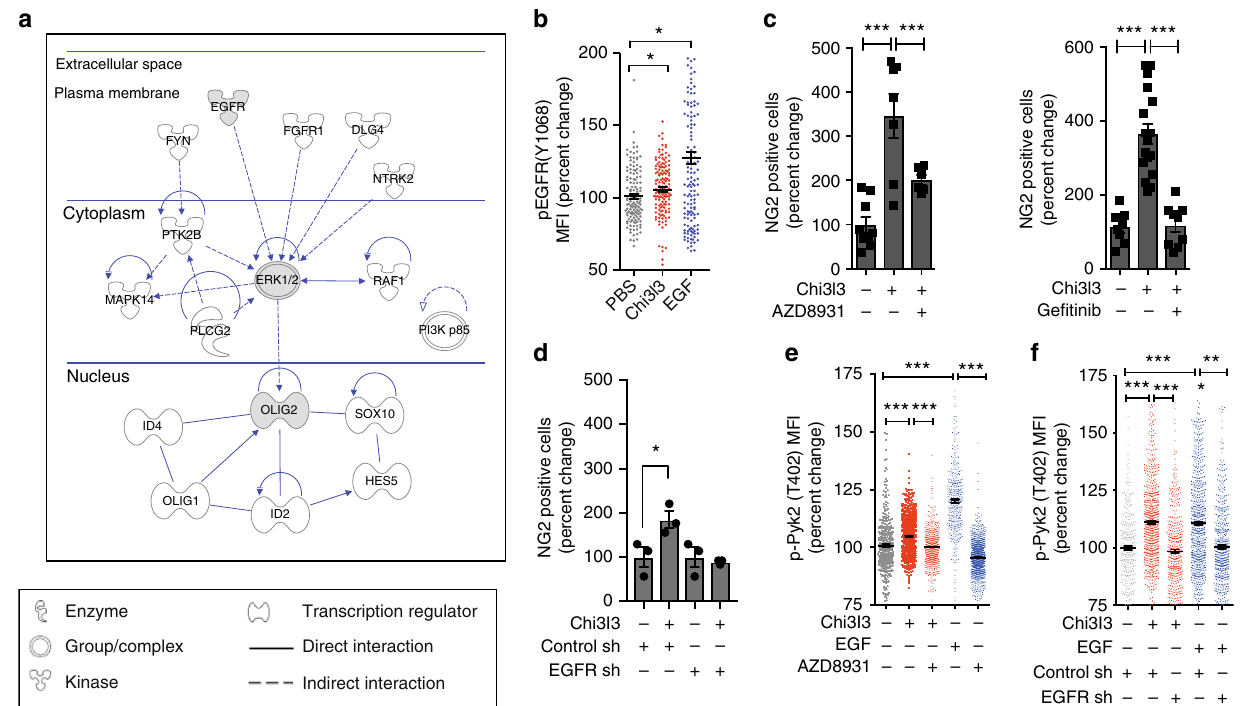
Fig. 4 Chi3l3 promotes oligodendrogenesis by inducing EGFR signaling. a ingenuity pathway analysis showing membrane-bound receptors (EGFR, FGFR1, DLG4 (PSD95), NTRK2, FYN) upstream of Chi3l3-induced MAPK signaling (Ptk2b (Pyk2), MAPK14 (p38MAPK), PLCG2 (PLC γ 2), RAF1 (c-Raf), ERK1/2, PI3K p85) and pro-oligodendrogenic transcriptional pattern ( Olig1, Olig2, Sox10, Hes5 , Id2 , Id4 ). b Mean fl uorescence intensity (MFI) quanti fi cation of individual neural stem cells (NSCs), activated by Chi3l3, EGF, or PBS (control) for 15 min, and immunostaining for phospho (p)-speci fi c EGFR (Tyr1068). One-way-ANOVA with Dunn ’ s multiple comparison test; c Quanti fi cation of NSC-derived NG2 + oligodendrocyte precursor cells after 3 days